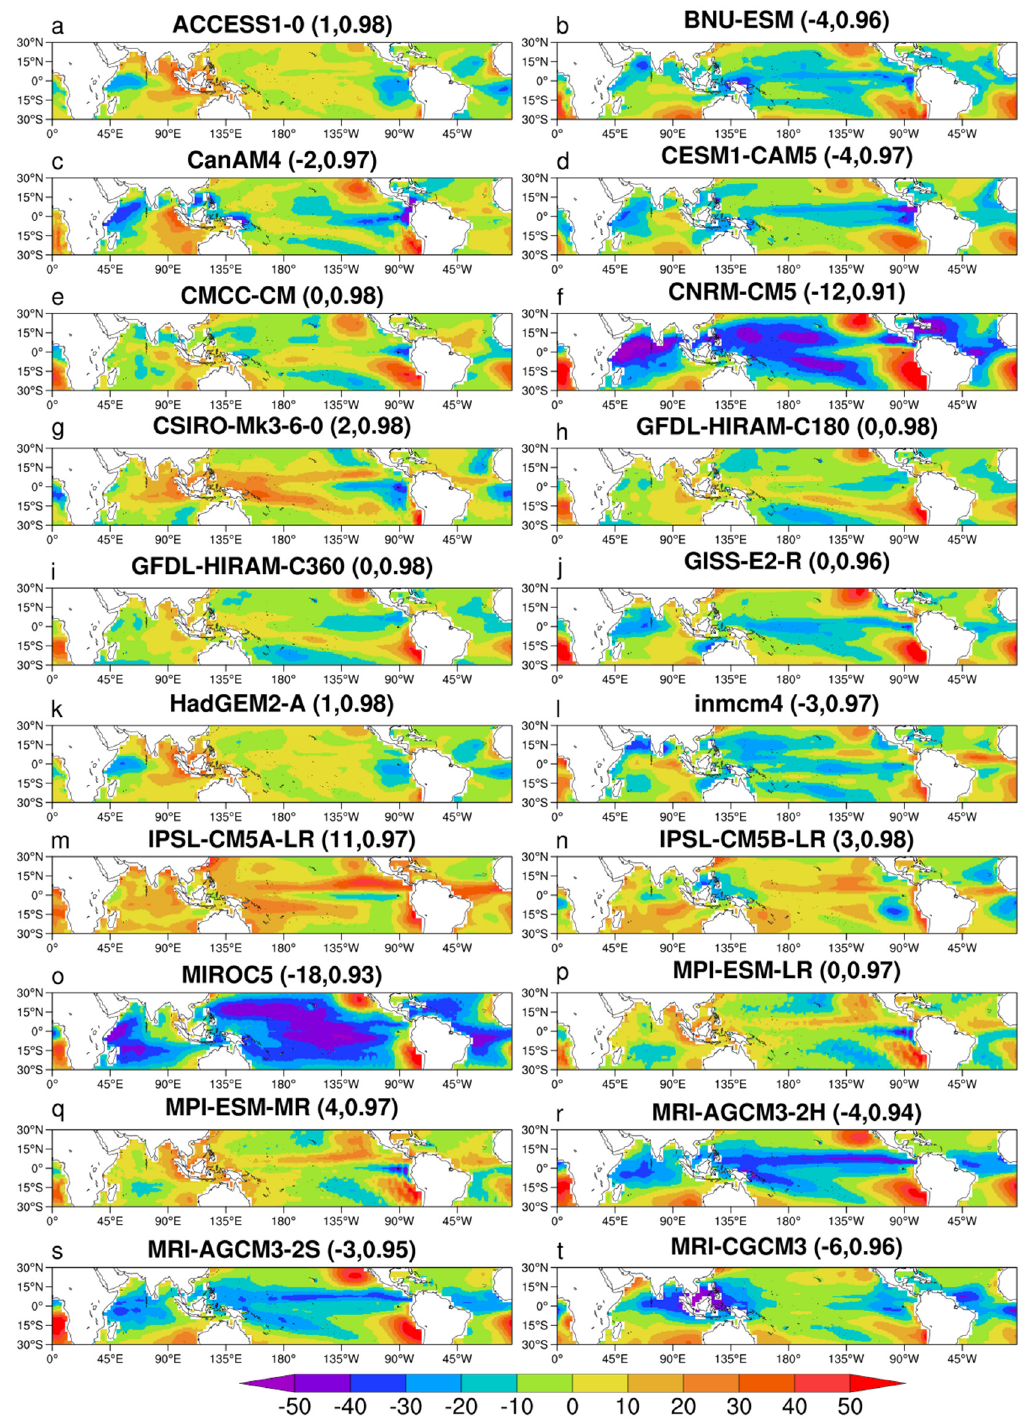
Figure 4. Mean bias in the net surface shortwave Q SW estimated as model minus OAFLux over the tropical oceans. The numbers in the parentheses show the mean bias and correlation coefficient. (unit: W m − 2 ).